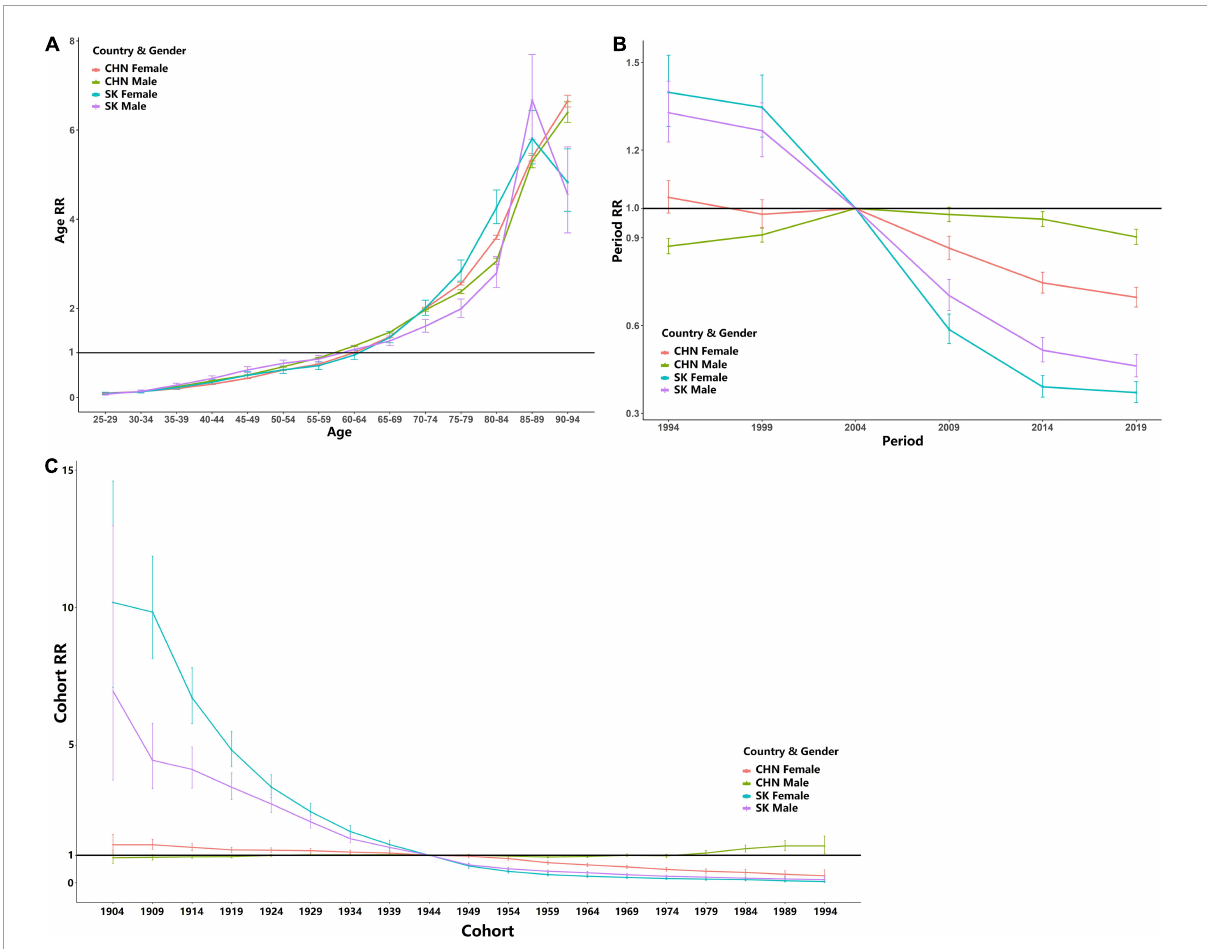
FIGURE4 Long-term effects of age, time period, and birth cohort for both genders in China (CHN) and South Korea (SK). The reference line (RR = 1) was also plotted. (A) Age RR; (B) period RR; (C) cohort RR (error bars stand for 95% confidence